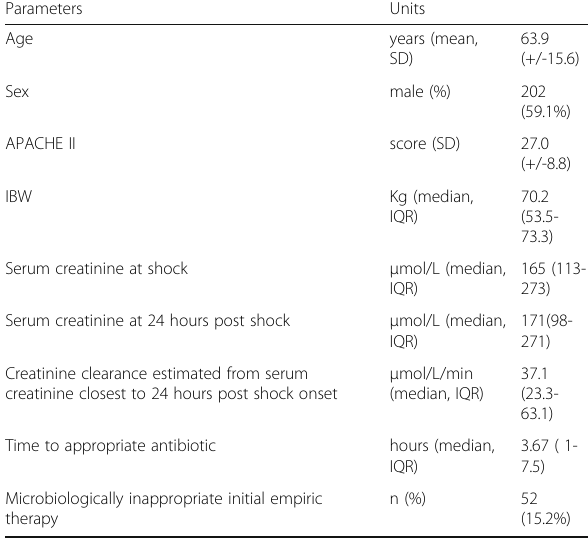
Table 1 (abstract 0261). Cohort characteristics (n=342 patients)